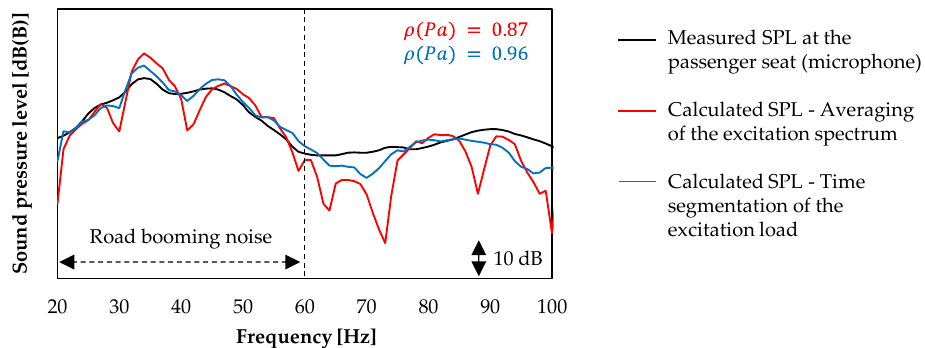
Figure 4. Comparison of the measured and calculated sound pressure level of a vehicle for driving on a rough road (test track, non-uniform road profile at 40 km/h). The black curve represents the measured sound pressure level of a microphone at the head position on the front passenger seat. To account for low-frequency noise components, we use a B-weighting function. The calculated sound pressure level using the averaging of the excitation spectrum approach equals the red curve. Here, the chassis internal forces have been measured and determined simultaneously with the measurement of the sound pressure with the microphone. The blue curve corresponds to the time segmentation of the excitation load approach. The data used for the calculation of the sound pressure level for the two different approaches are the same.